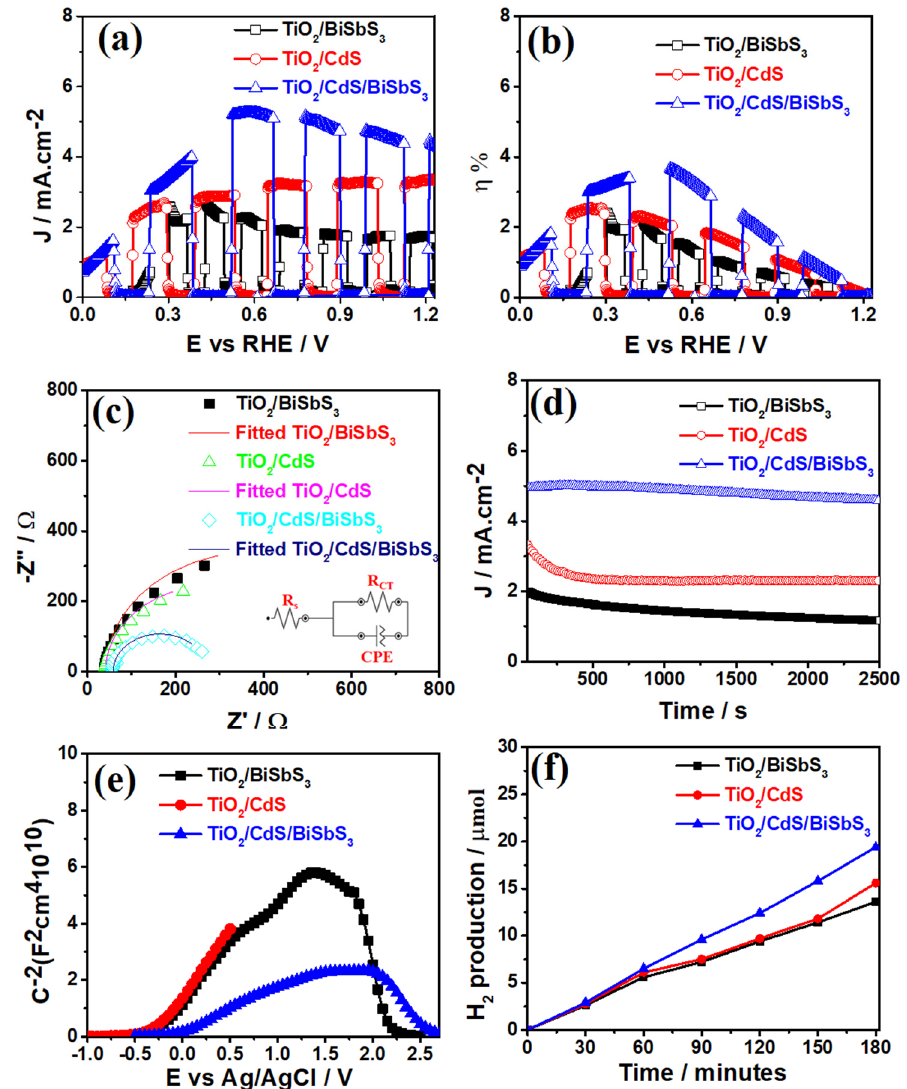
Figure 5. Photocatalytic properties of fabricates electrodes TiO 2 /BiSbS 3 , TiO 2 /CdS, and TiO 2 /CdS/BiSbS 3 ( a ) LSV curves, ( b ) Solar to hydrogen efficiency plot, ( c ) EIS studies, ( d ) Photostability response, ( e ) Mott–Schottky (M-S) plot and, ( f ) Temporal evolution of H 2 gas (0.1 M Na 2 SO 4 ). Furthermore, the semiconducting properties of the electrodes were also analyzed us- ing Mott–Schottky (MS) plots in Figure 5e, which reveal that TiO 2 /CdS has an n-type be- havior of the electrodes with positive slop, whereas TiO 2 /BiSbS 3 and TiO 2 /CdS/BiSbS 3 have inverted V-shape plots that confirm the p-n junction formation between n-type TiO 2 , TiO 2 /CdS, and p-type BiSbS 3 [44]. Typically, a high charge carrier density is delivered by the electrode with the minimum slope for the M-S plot. Impressively, compared to the TiO 2 /CdS or TiO 2 /BiSbS 3 electrodes, the TiO 2 /CdS/BiSbS 3 photoelectrode displays a lower slope with a high charge carrier concentration in Figure 5e. Additionally, all of the elec- trodes’ flat band potentials (V FB ) range from 0.1 to − 0.5 V. This evidence supports the pho- togenerated carriers’ quick transport or poor recombination as well as the elevated PEC hydrogen generation. As shown in Figure S9, TiO 2 , CdS, and BiSbS 3 M-S plots demon- strate that TiO 2 and CdS are n-type semiconductors, whereas BiSbS 3 is a p-type semicon- ductor. In theory, the flatband band (V FB ) is assumed to be position of the conduction band for n-type materials and the valance band for p-type materials [45]. TiO 2 has a CB value